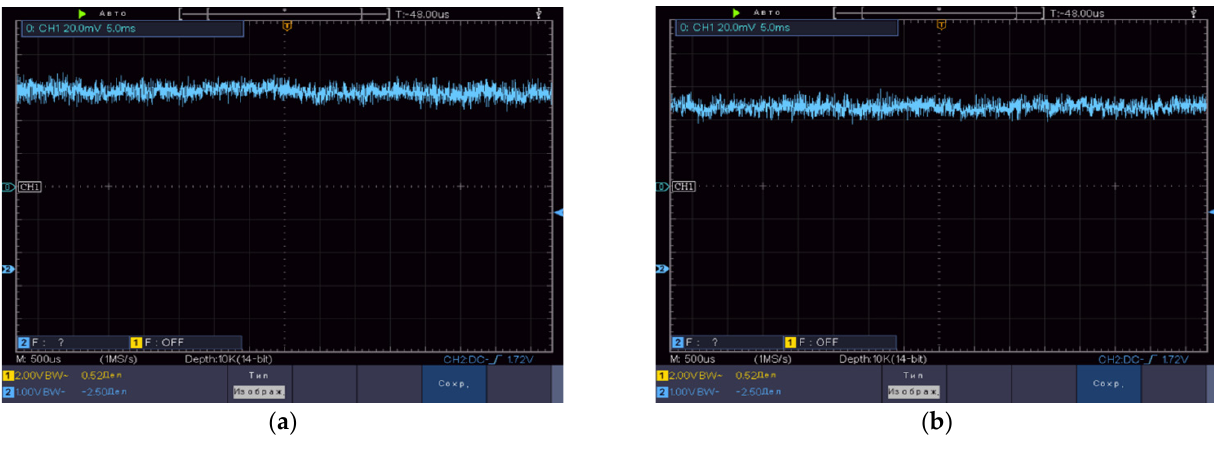
Figure 11. Levels of the signals registered by optical probes on the measure when the ( a ) near 940 nm LED or the ( b ) far 940 nm LED are turned on.